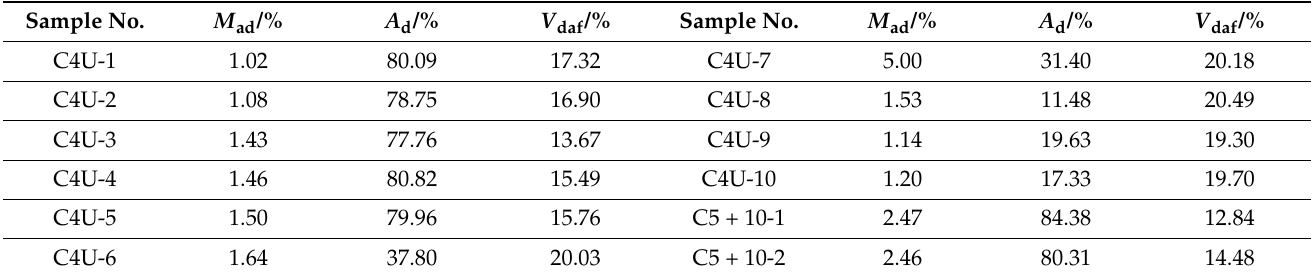
Table 1. Proximate analysis data of coal and carbonaceous mudstone samples.